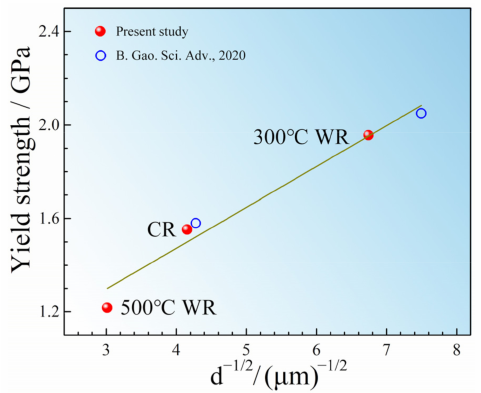
Figure 7. Relationship between YS and lamellar thickness in the nano-lamellar steels. Data from